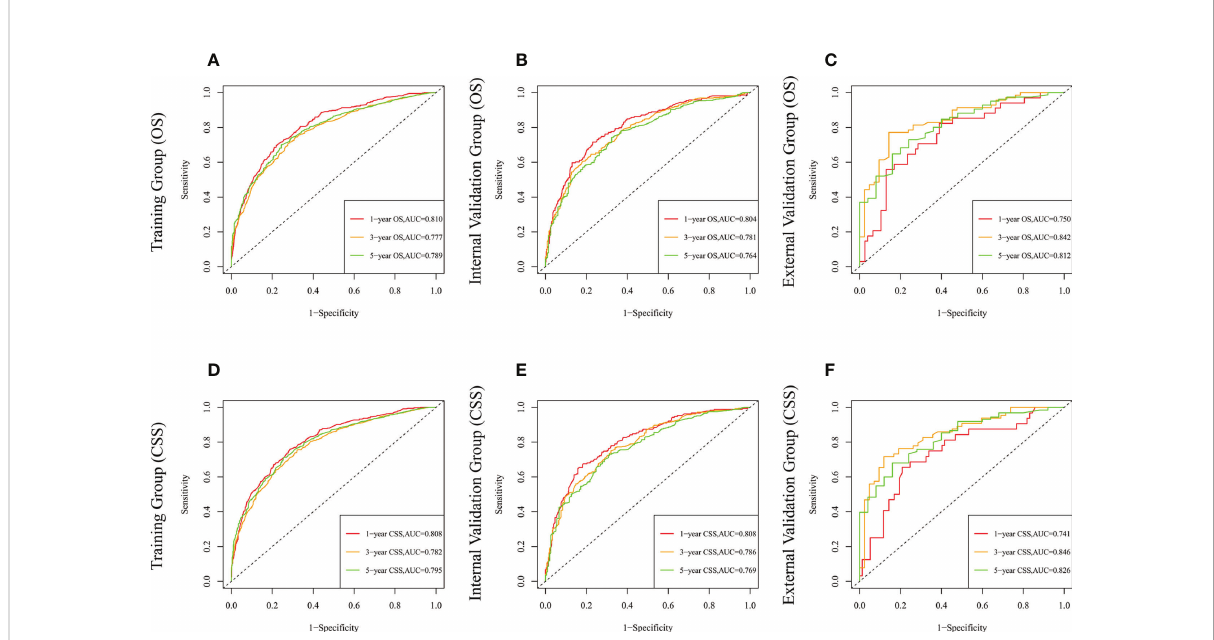
FIGURE 5 The time-dependent ROC curves of the nomogram predicting OS at (A) 1-year and 3-year and 5-year in the training cohort, and at (B) 1-year 3- year and 5-year in the internal validation cohort, (C) 1-year and 3-year and 5-year in the external training cohort. The time-dependent ROC curves of the nomogram predicting CSS at (D) 1-year and 3-year and 5-year in the training cohort, and at (E) 1-year 3-year and 5-year in the internal validation cohort, (F) 1-year and 3-year and 5-year in the external training